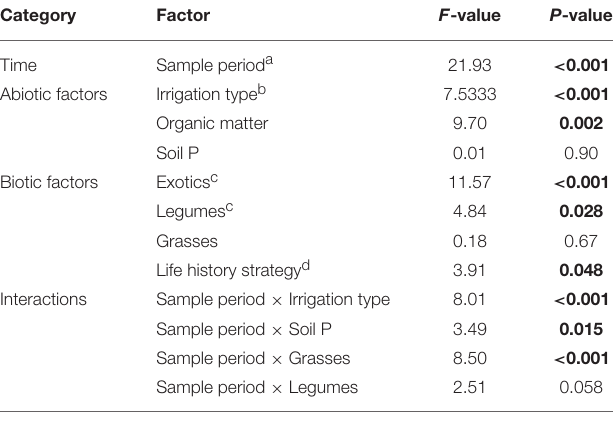
TABLE 2 | Effect of sampling date and biotic and abiotic factors in the model of Beauveria bassiana abundance as tested using Satterwaite type III approximation for degrees of freedom (Model AIC: 2,166, R 2 fixed = 0.19).